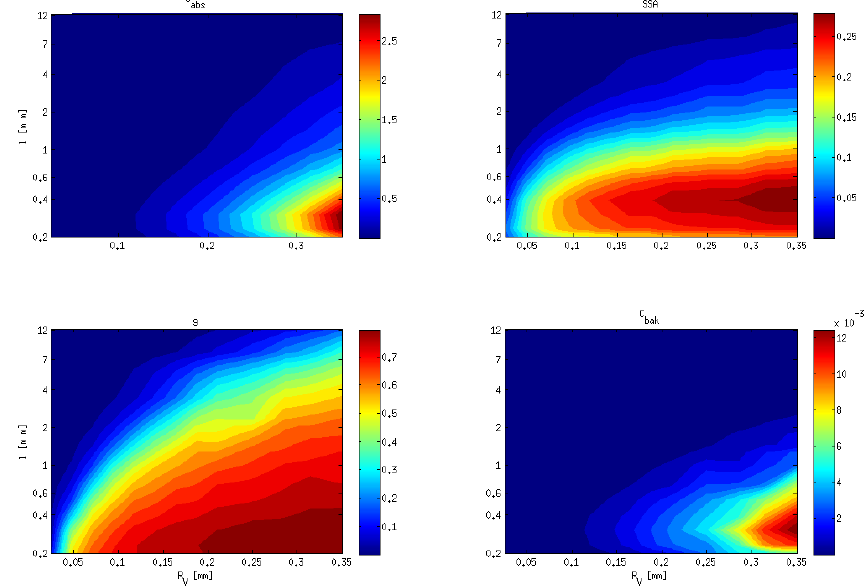
Figure 2. Absorption cross section C abs (upper left), single-scattering albedo SSA (upper right), asymmetry parameter g (bottom left), and backscattering cross section C bak (bottom right) of black carbon aggregates as a function of volume-equivalent radius R V and wavelength λ